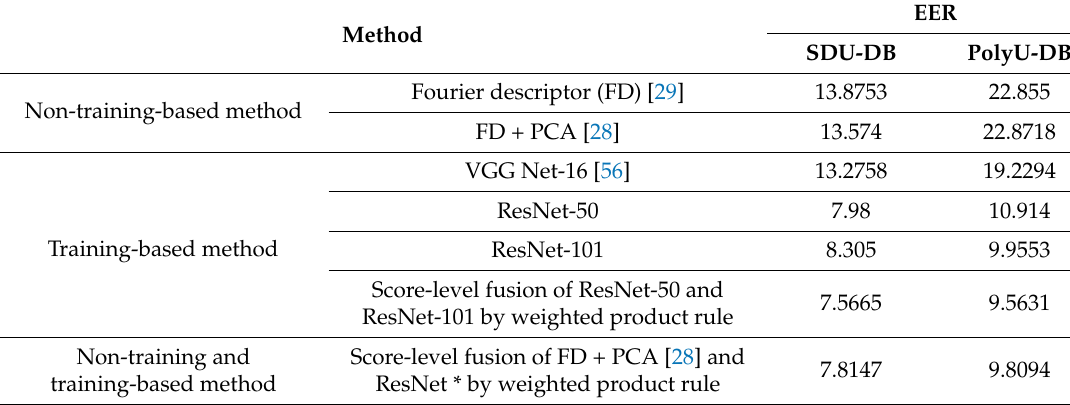
Table 6. Comparison of finger shape recognition accuracy (unit: %) (*: ResNet-50 is used for SDU-DB whereas ResNet-101 is used for